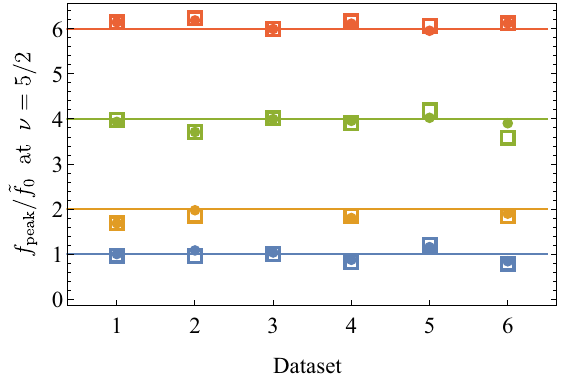
FIG. 12. Frequencies corresponding to the most prominent spectral peaks at ν ¼ 5 = 2 in six different datasets from different samples and preparations. Frequencies are normalized by which is the parameter obtained by applying linear fit to each observed set of peak frequencies (shown in circles) with the assumption that they correspond to integer multiples of this fundamental frequency. Open squares correspond to the frequen- cies obtained by taking the average value of the two frequencies that mark the width at half maximum for each peak, normalized by the same coefficients. The dataset identification is as follows: 1, sample 2, preparation 2; 2, same sample and preparation four days later; 3, sample 2, preparation 1; 4, sample 5, preparation 2; 5, sample 3, preparation 1; 6, sample 4, preparation 1. Note that two of the samples do not exhibit peaks at or near 2 f 0 ; cf. traces in Figs. 14(a) and 14(b) corresponding to datasets 3 and 2 shown here. T ∼ 20